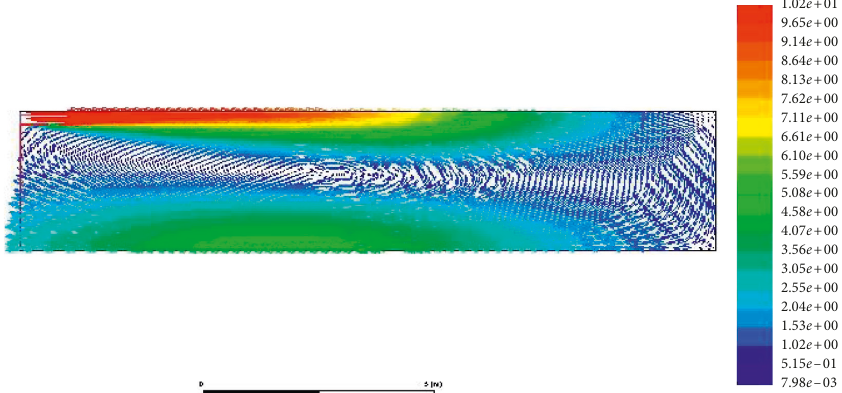
Figure 8: Wind flow velocity vector.